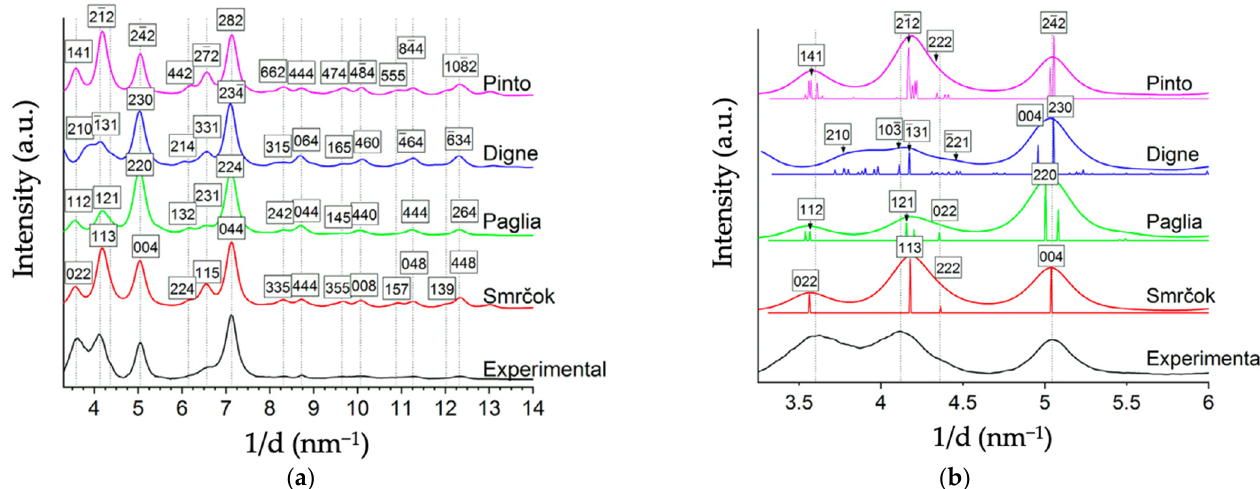
Figure 7. ( a ) Azimuthally averaged line profile of experimental SAED pattern obtained by Ayoola et al., plotted with the simulated diffraction data for each of the theoretical models considered. Dashed lines indicate the peaks in the experimental diffraction profile. ( b ) A closeup image of the region from 3.0–6.0 nm − 1 from ( a ) showing the contributing peaks to the profile. The diffraction profiles of the models agree well overall with the experimental profile; however, the monoclinic non-spinel (Digne) model lacks the first peak present in the experimental pattern. Reprinted (adapted) from Acta Materialia, Vol 182, Henry O. Ayoola, Stephen D. House, Cecile S. Bonifacio, Kim Kisslinger, Wissam A. Saidi, Judith C. Yang, Evaluating the accuracy of common γ -Al 2 O 3 structure models by selected area electron diffraction from high-quality crystalline γ Al 2 O 3 , pp 257–266, Copyright 2020, with permission from Elsevier.